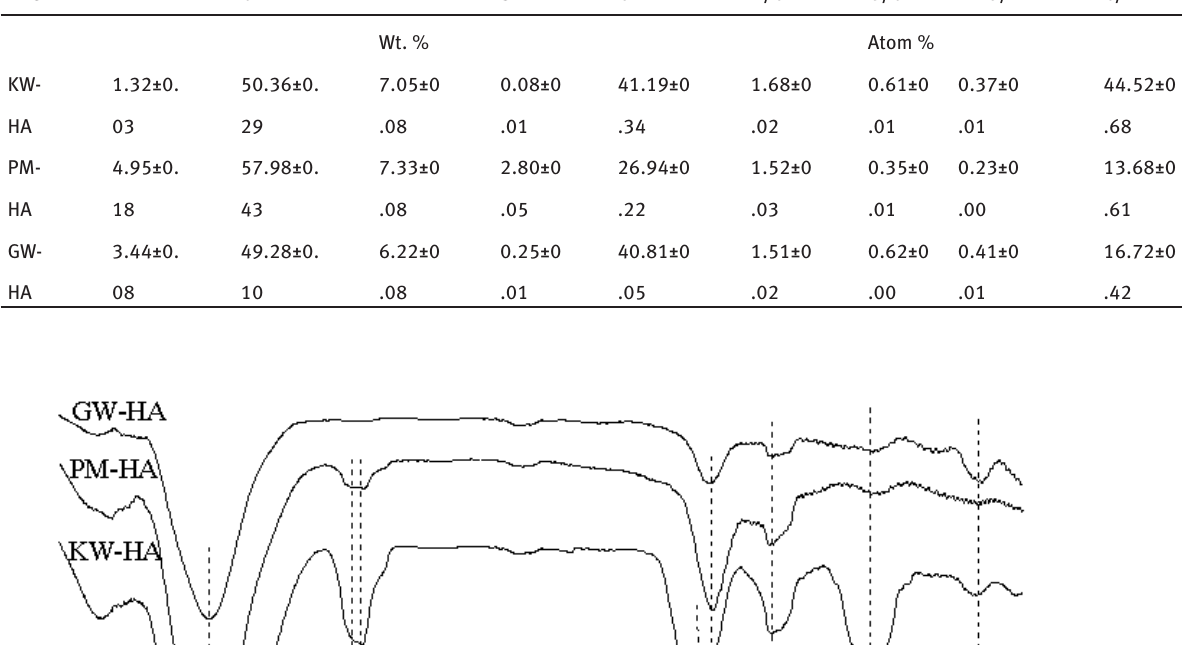
Table 2: Elemental analysis of HAs extracted from KW, PM and GW. HAs